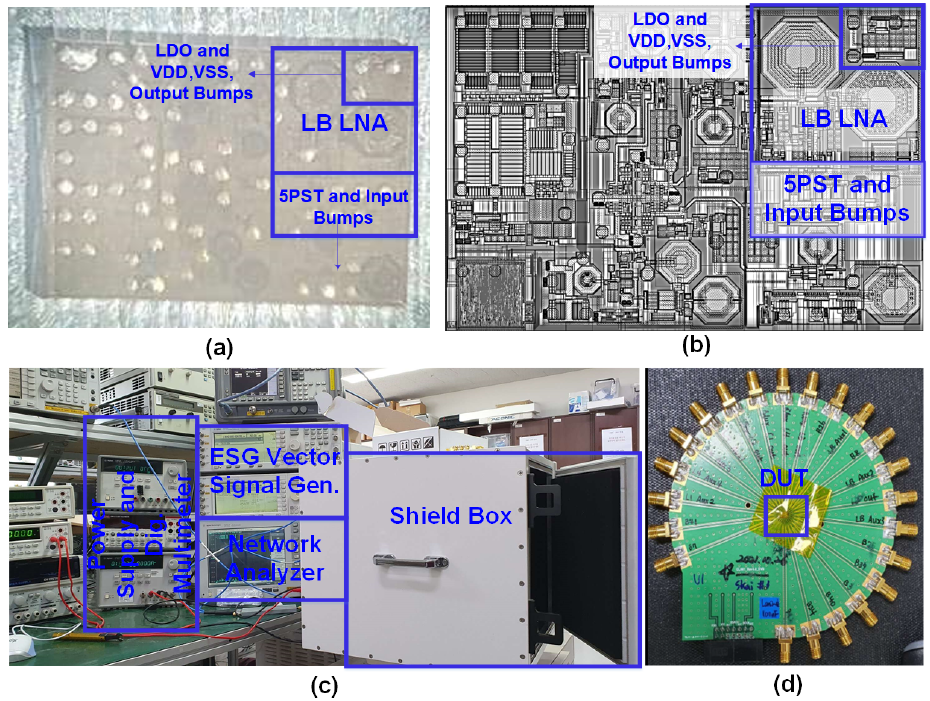
Figure 4. ( a ) Chip micro-photograph, ( b ) layout, ( c ) measurement environment, ( d ) PCB and device under test, of the designed low band LNA as a part of diversity RF front-end for 2G/3G/4G/5G multi-mode cellular handsets.